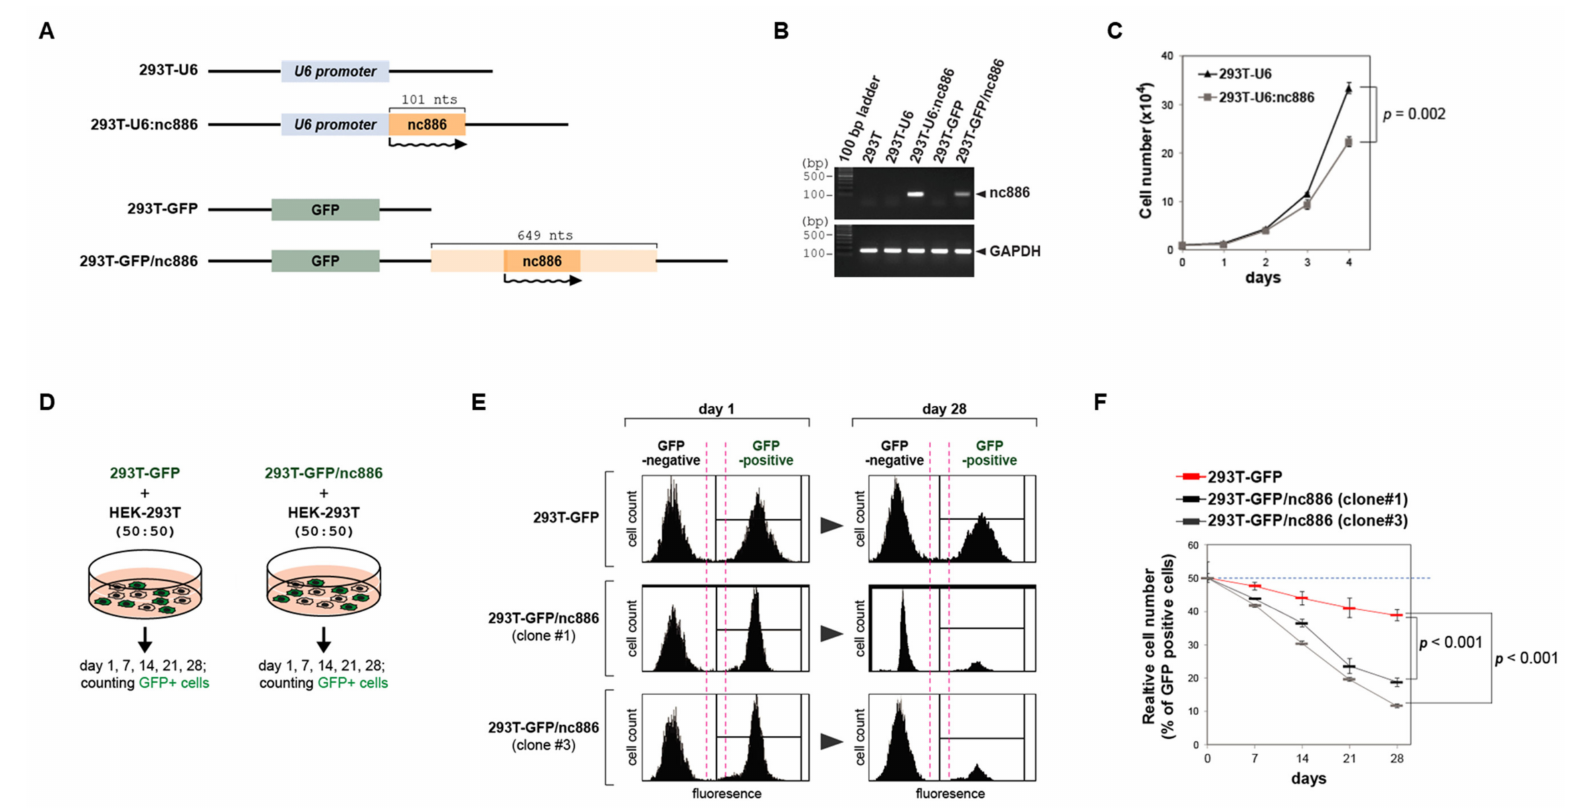
Figure 1. nc886 inhibits cell growth when ectopically expressed in 293T cells. ( A ) Simplified diagrams depicting the feature of plasmids used to construct pairs of an nc886 + cell line and the corresponding control nc886 − line from the parental 293T cells (see the text for details). Names of cell lines are indicated on the left. nc886 transcripts are illustrated by wavy lines, with an arrowhead designating the transcriptional direction. ( B ) RT-PCR measurement of nc886 and GAPDH as a control. ( C ) Cell proliferation shown by cell numbers. After plating the same number of cells at day 0, cell numbers were counted every indicated day. Mean values and standard errors from triplicate samples are shown, with a p -value at day 4 indicated. ( D ) An illustration of the cell mixing experiments for panels E,F. ( E , F ). Fluorescence activated cell sorting (FACS) profiles for counting green fluorescent protein (GFP)-negative and -positive cells. Representative FACS data at day 1 and 28 are shown in panel E. At indicated days, % of GFP-positive cells were calculated from the FACS data and are plotted (panel F). Red line designates 293T-GFP; black and grey lines designate clone #1 and #3 of 293T-GFP / nc886. p -values (from triplicate samples) are for 28-day